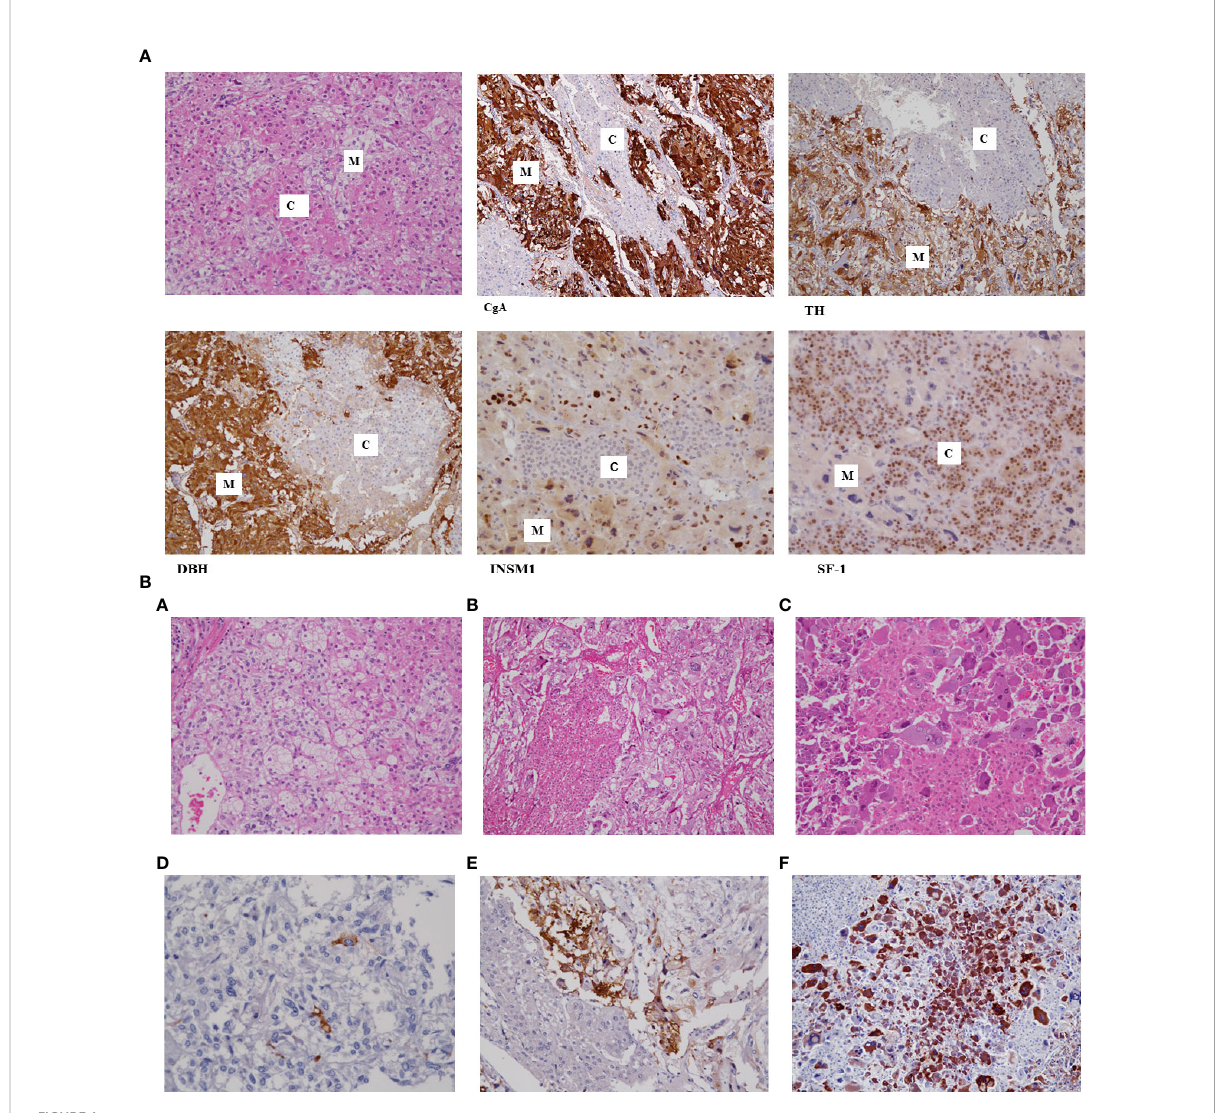
FIGURE 1 (A) Histology of mixed corticomedullary tumor (MCMT) with immunohistochemistry. The tumor is composed of nests of cortical cells with eosinophilic cytoplasm and round nuclei (C) and medullary cells with pale cytoplasm and hyperchromatic, irregularly shaped nuclei (M). Cell nests of medullary cells are positive for chromogranin-A (CgA), tyrosine hydroxylase (TH), dopamine beta-hydroxylase (DBH), and INSM1; however, cortical cells are negative for all these biological markers but positive for SF1. (B) Histology of three cases of MCMTs with subclinical Cushing syndrome. Three cases of MCMT are demonstrated. The upper and lower lines are the same cases subjected to hematoxylin-eosin and adrenocorticotropic hormone (ACTH) immunohistochemical staining, respectively. Tumor cells in the left line show mild atypia in both cortical cells and medullary cells (A), and there are few ACTH-positive cells (D). Nests of medullary cells in the middle line show small and large irregular nuclei (B) and stain positively for ACTH in the adjacent area of cortical cells (E). Medullary cells in the right line have irregularly shaped